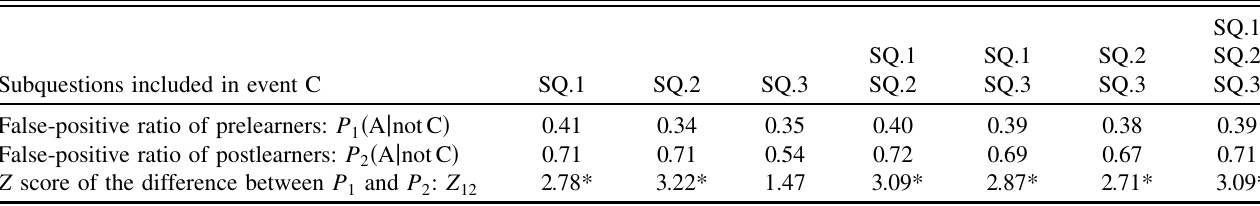
TABLE IV. The relation between the subquestions of Q.7 and the false-positive ratios.